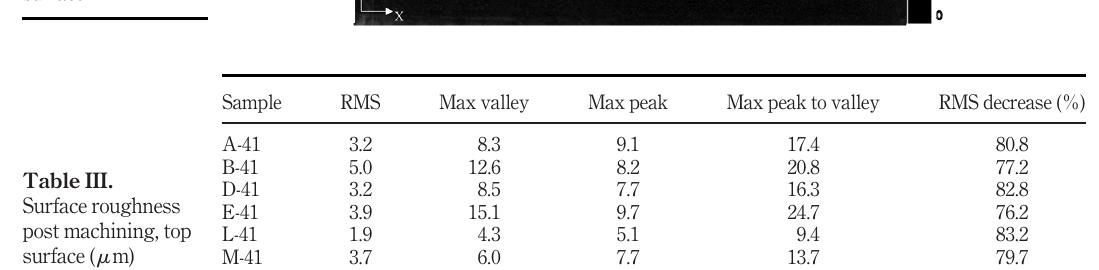
Figure 4. Example of C-scan, center 0.635cm of sample through top surface